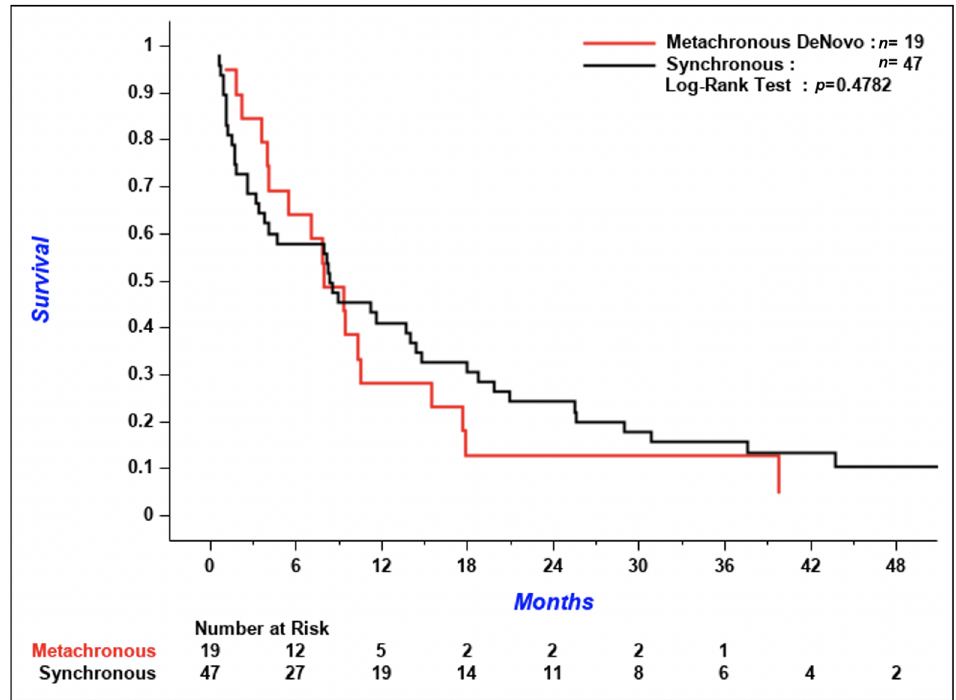
Figure 5. Time from diagnosis of CNS metastases to death in patients with synchronous CNS metastases versus de novo metachronous CNS metastases. CNS = central nervous system.